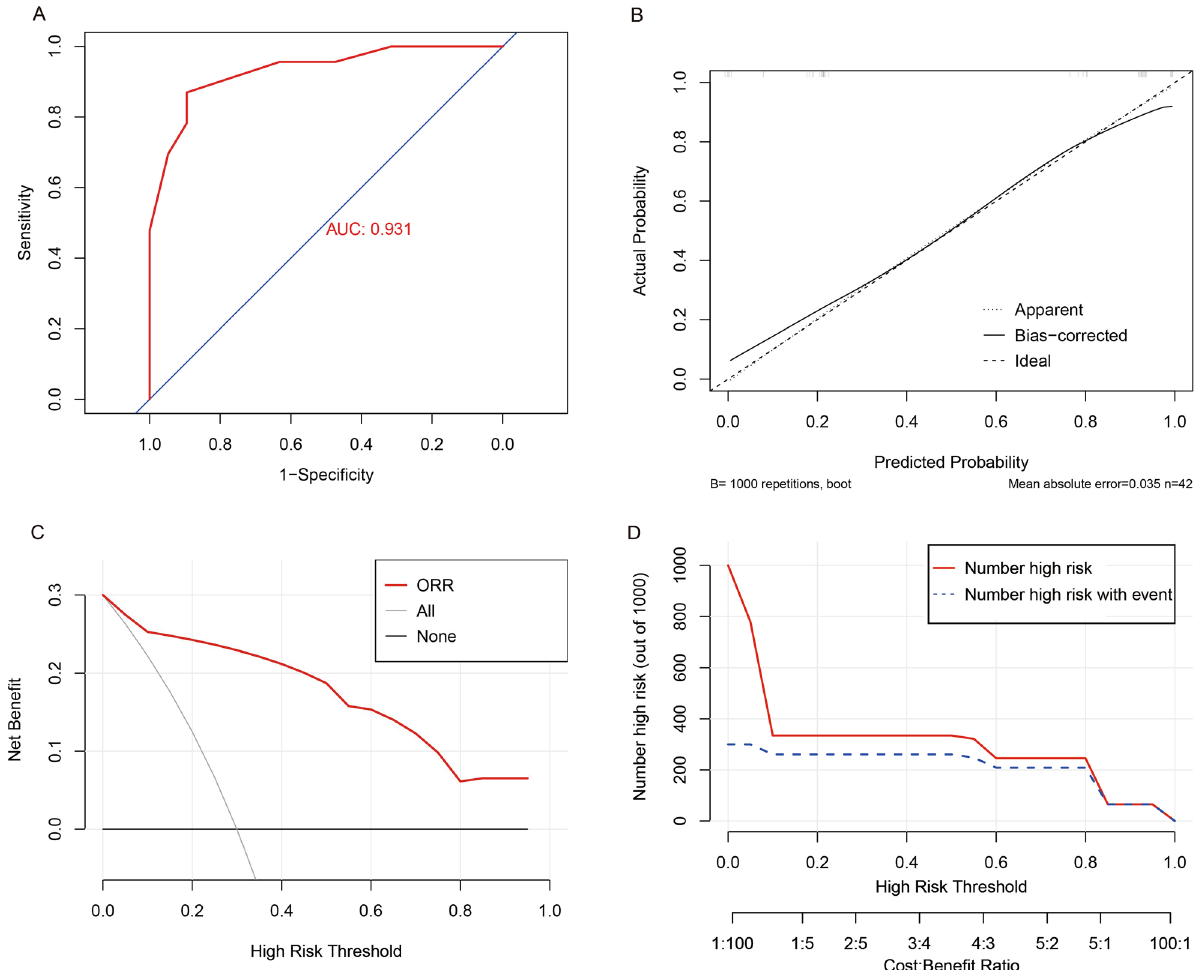
Figure 3. Internal validation of the nomogram for predicting the ORR after neoadjuvant therapy from training cohort. ( A ). Receiver operating characteristic curve. ( B ). Bootstrap validation curve. ( C ). Decision curve analysis. ( D ). Clinical impact curve. ORR, objective response